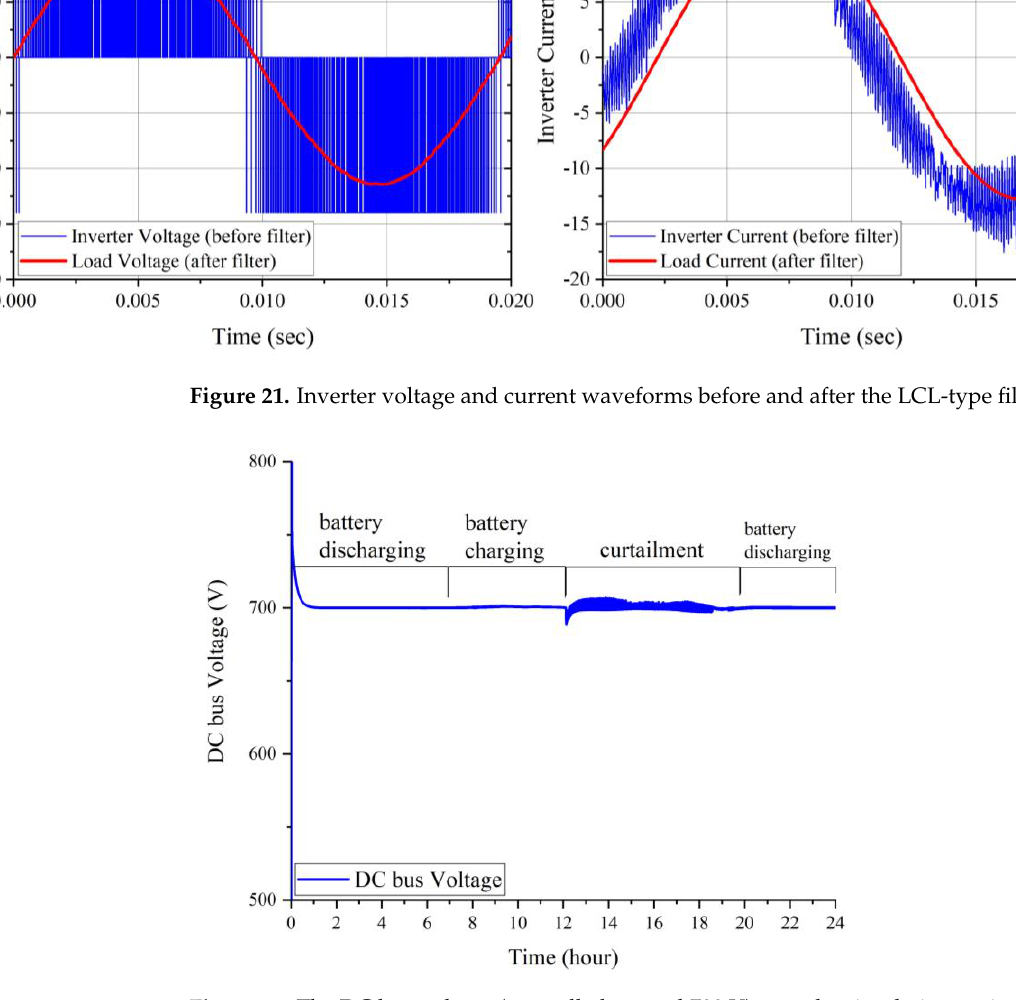
Figure 22. The DC bus voltage (controlled around 700 V) over the simulation period (24 h).